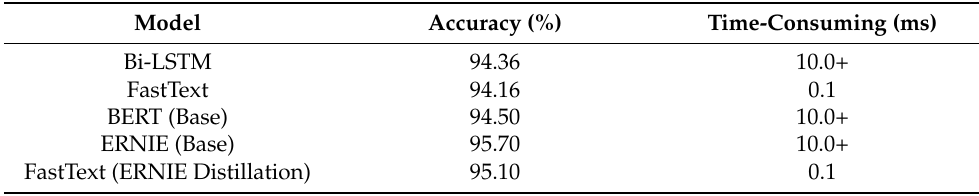
Table 4. Comparison of accuracy and time-consuming of different models.